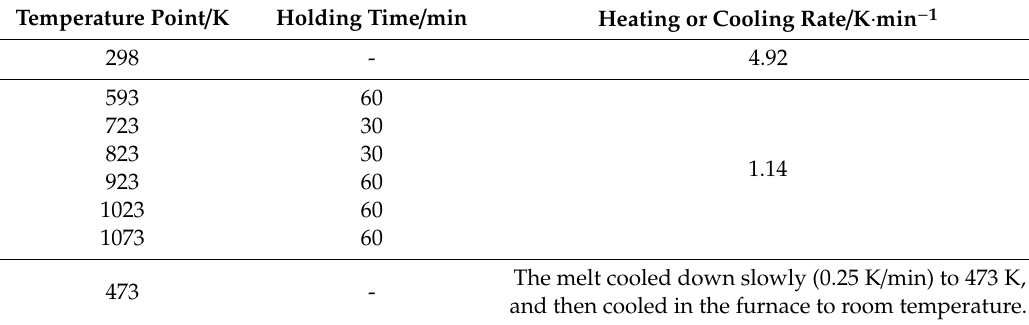
Table 1. The temperature control settings used for the synthesis of KBi(MoO 4 ) 2 crystal.